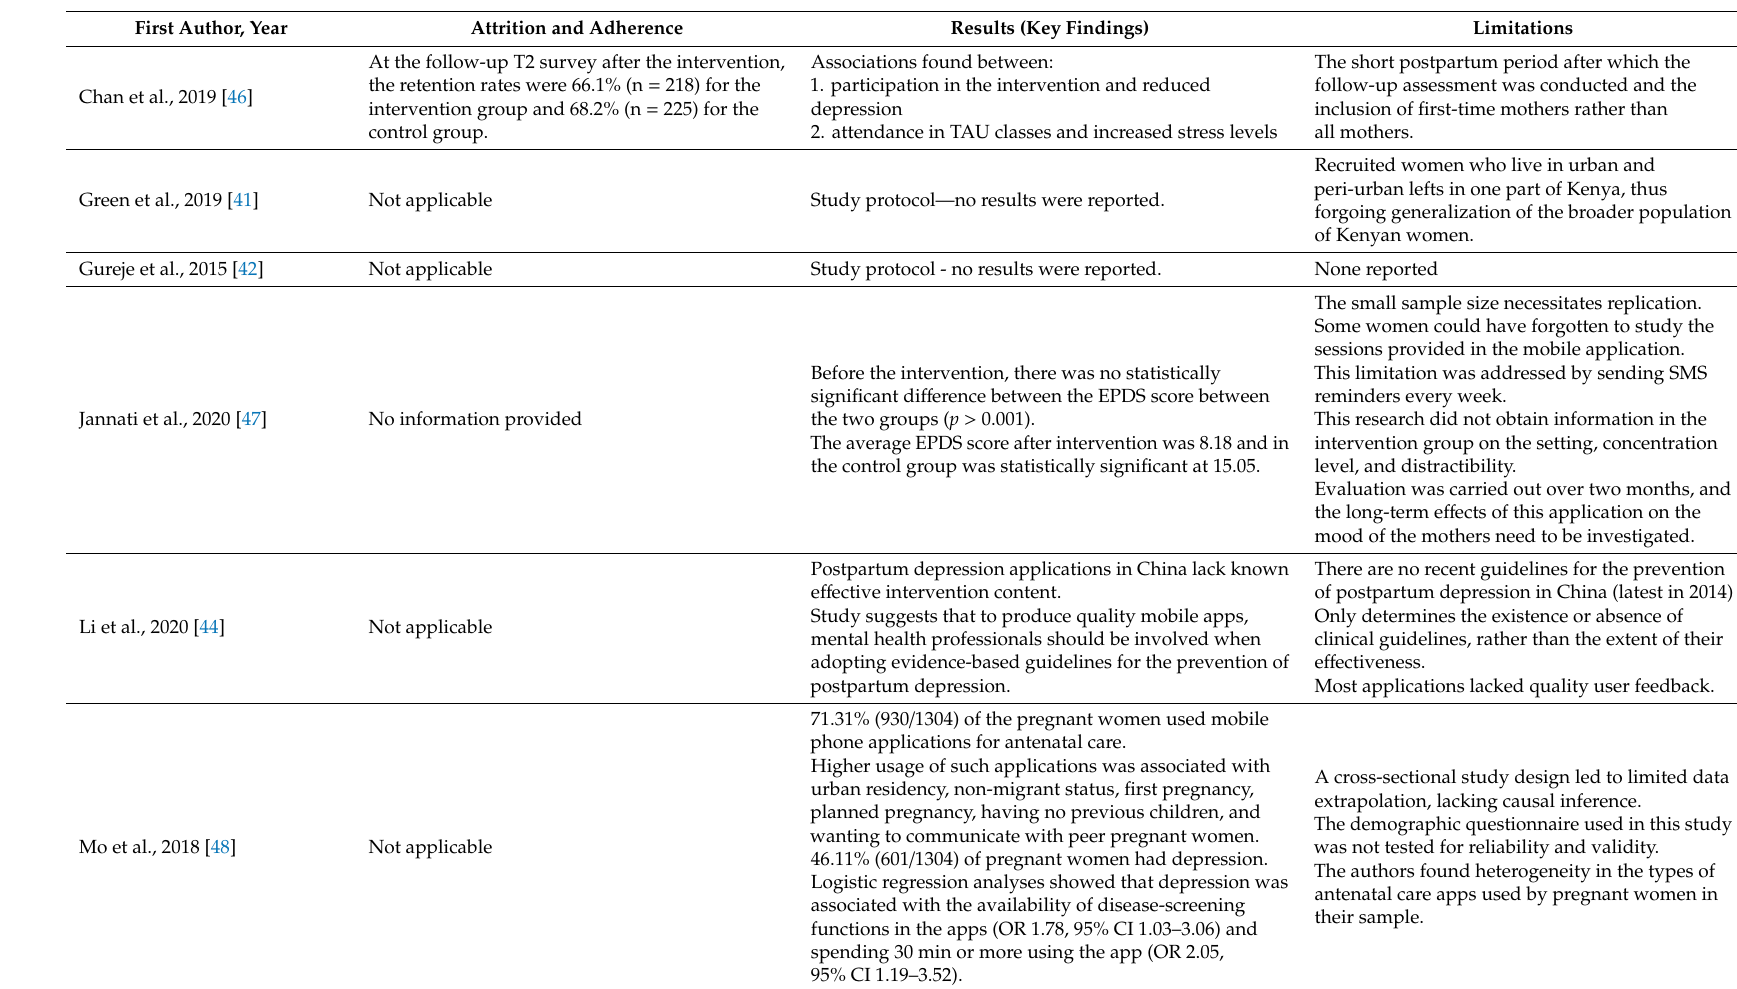
Table 4. Data extraction: results and